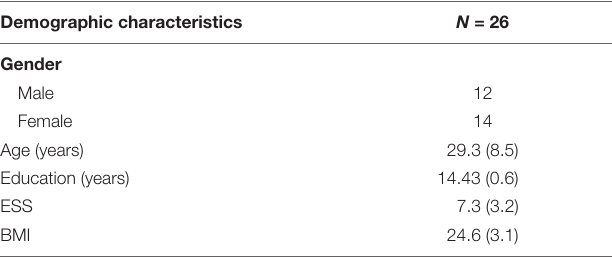
TABLE 1 | Demographic characteristics. Demographic characteristics